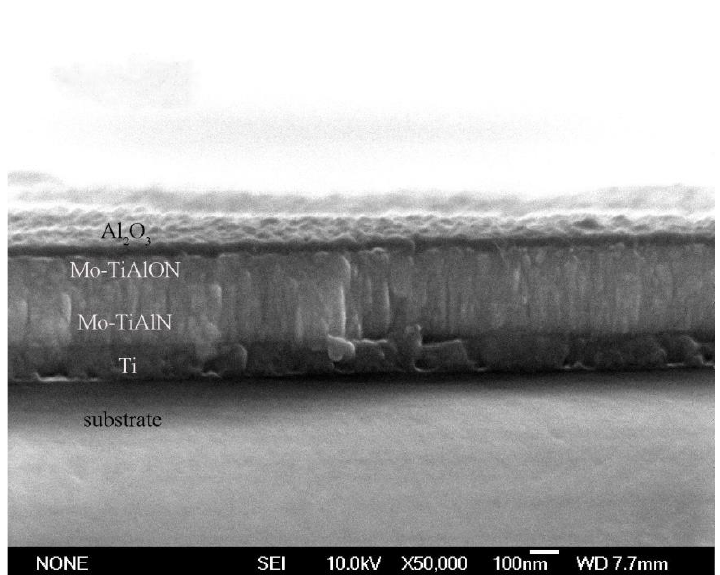
Figure 8. Cross-sectional morphology of TiMoAlON selective absorbing films.